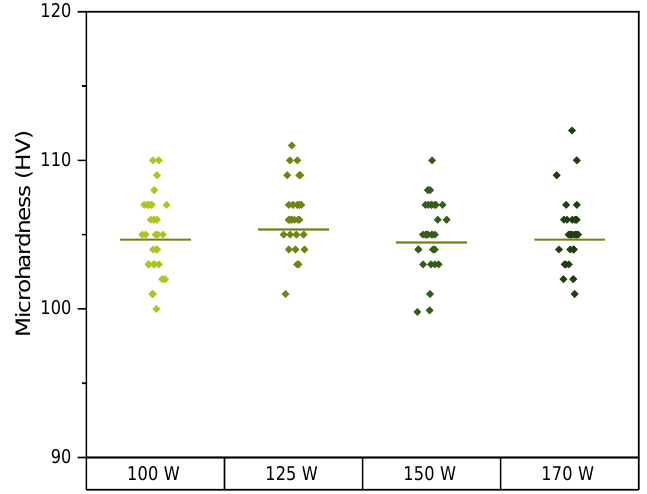
Figure 13. Results of Vickers microhardness tests for each power condition.